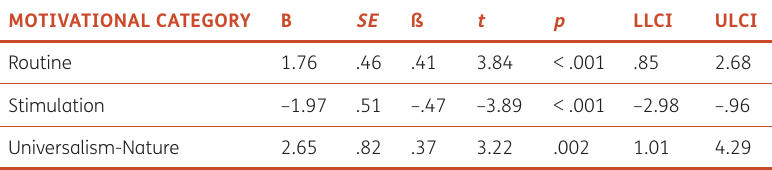
Table 3b Stepwise regression predicting participation duration in sample 2. R 2 = .279; F (3, 73) = 9.417, p < .001.